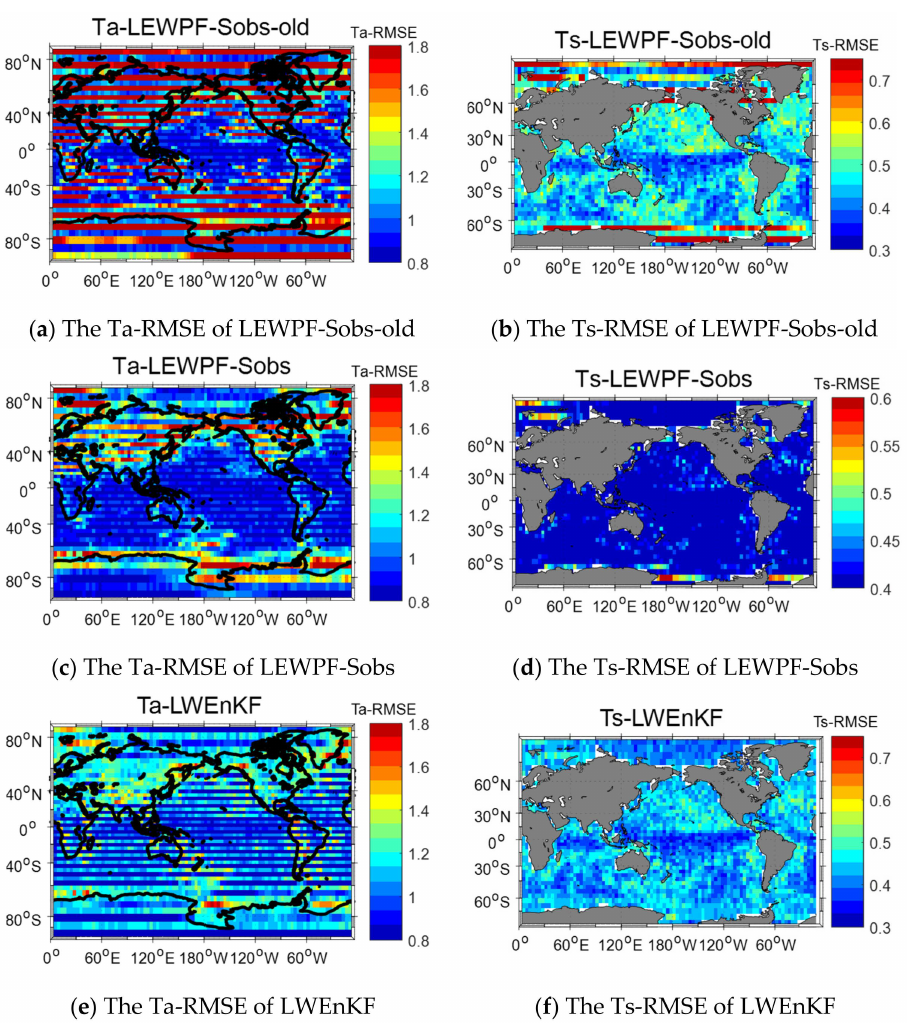
Figure 8. The spatial distribution of annual average RMSE of panel ( a , c , e ) the atmospheric tempera- ture ( T a ) use the spare observations and the RMSE with respect to LEWPF-Sobs-old, LEWPF-Sobs and LWEnKF. The panel ( b , d , f ) are similar to panel ( a , c , e ) but for the ocean temperature ( T s ) with standard